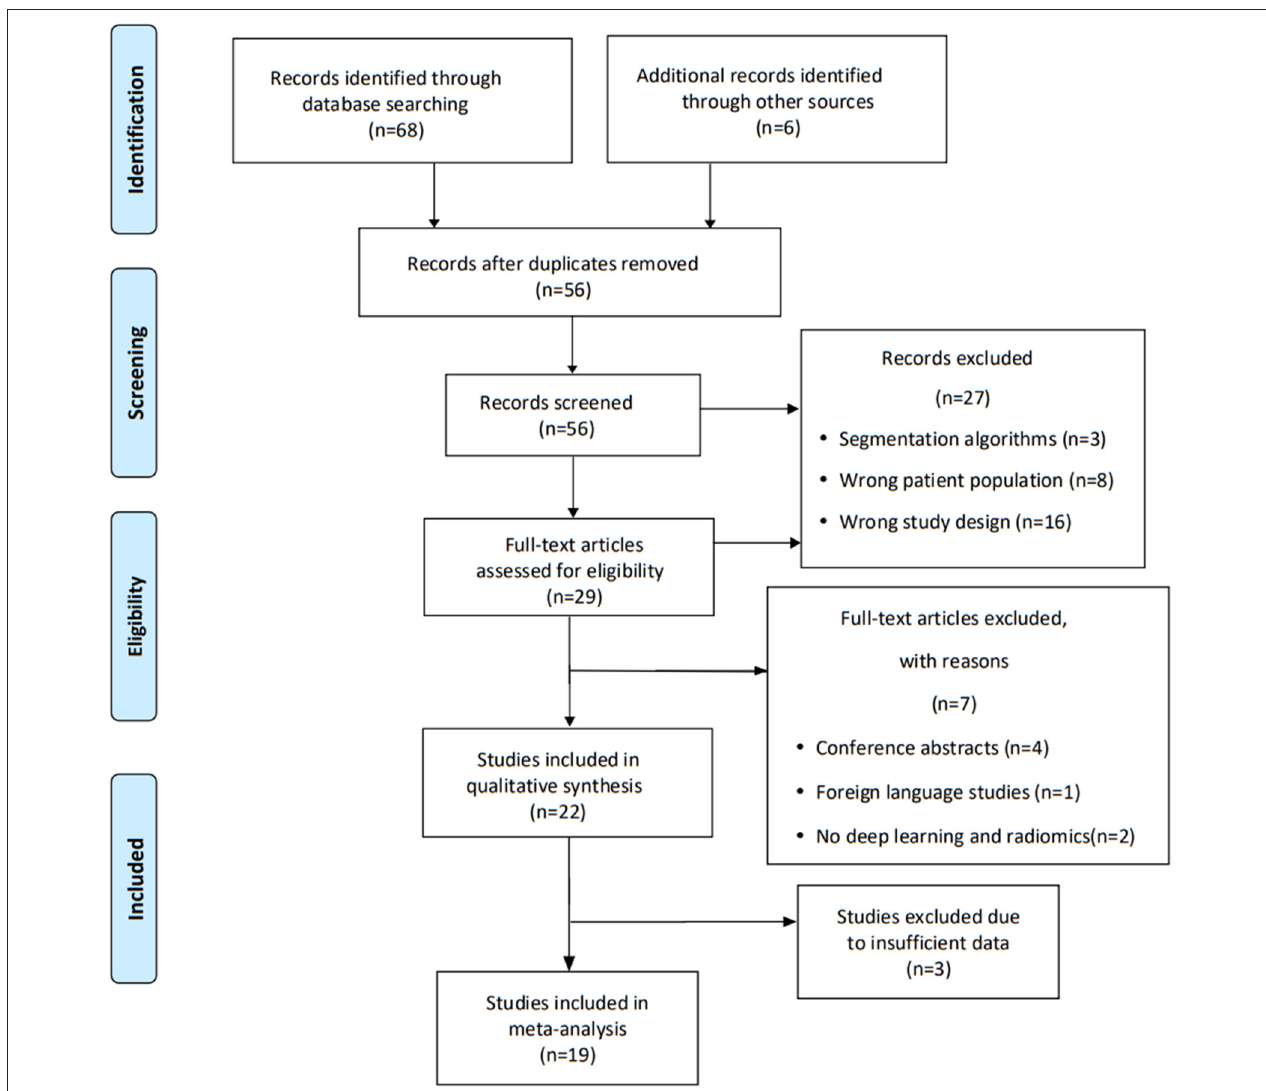
FIGURE 1 | PRISMA flow chart outlining the selection of studies for